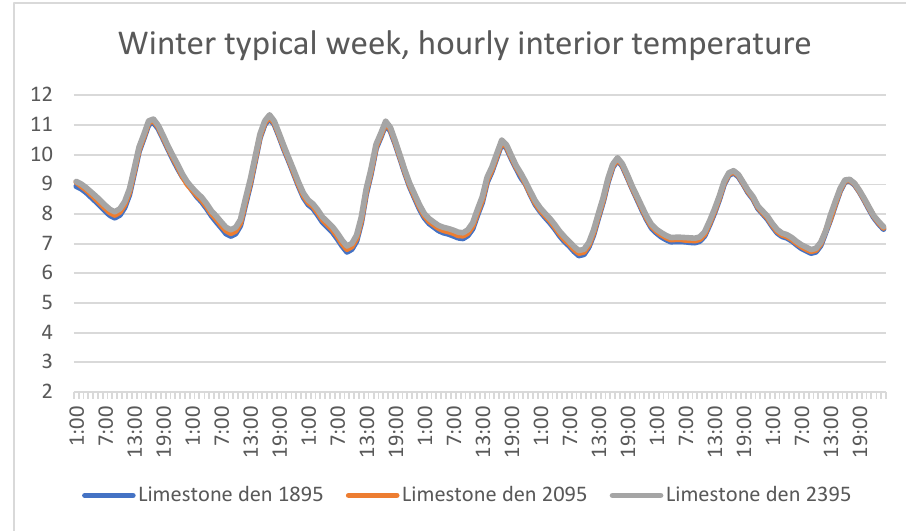
Figure 7. Typical winter week, hourly interior temperature. Table 3. Characteristics of stone of Girona and vaults